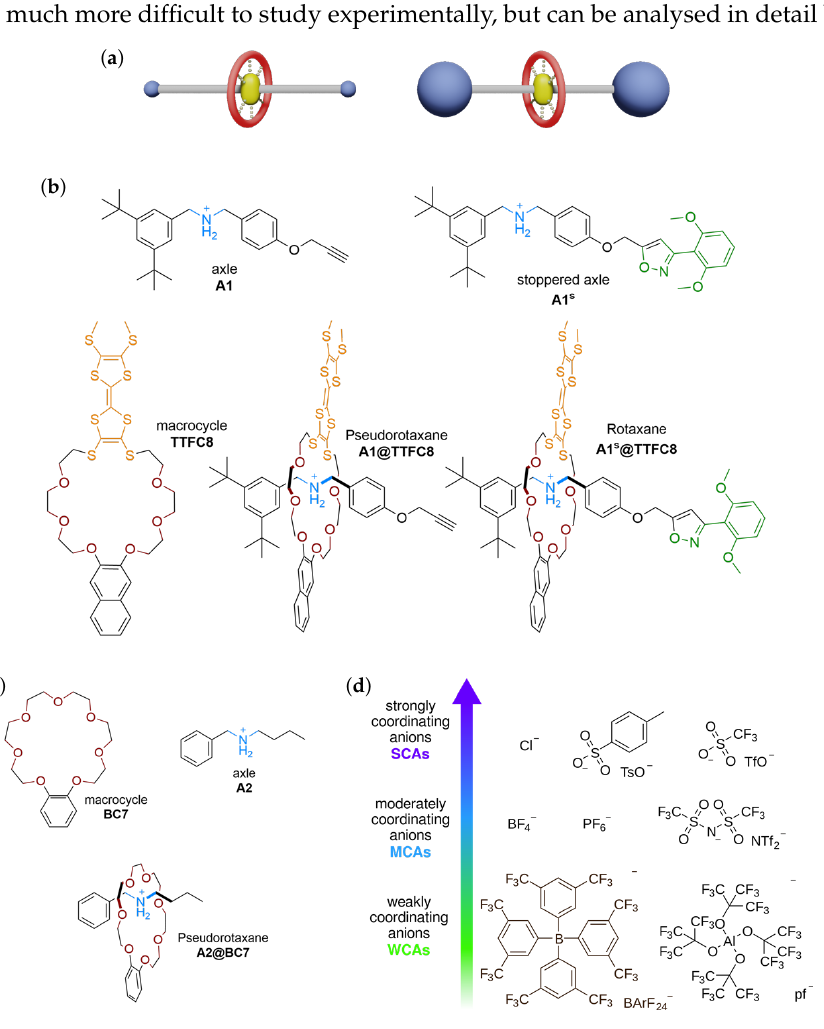
Figure 1. ( a ) Generic depiction of a pseudorotaxane (left) and a rotaxane (right) with non-covalent axle–wheel interactions indicated by dashed lines in the centre. ( b , c ) Supramolecular components